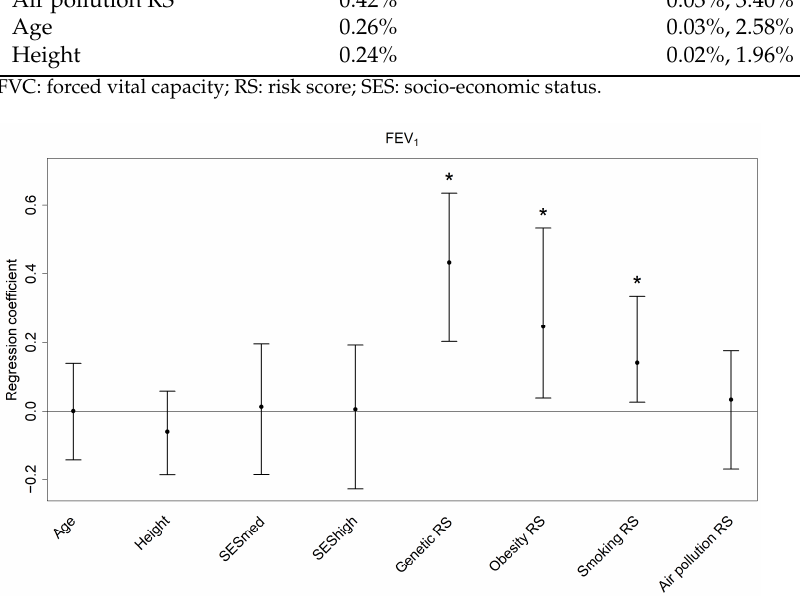
Figure 3. Regression coefficients (bootstrap median and 95% confidence interval) of the predictors for FEV 1 . The coefficients reflect the change in the z-score for one unit increase in the single predictors and one interquartile range increase in the risk scores. FEV 1 : forced expiratory volume in 1 s; RS: risk score; SESmed: medium socio-economic status (reference: low socio-economic status); SEShigh: high socio-economic status (reference: low socio-economic status); * p < 0.05.